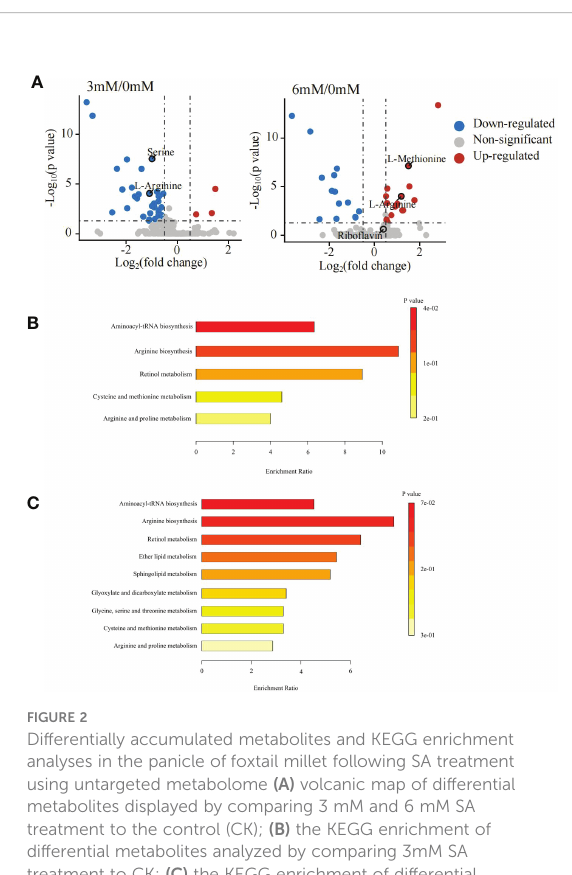
FIGURE 2 Differentially accumulated metabolites and KEGG enrichment analyses in the panicle of foxtail millet following SA treatment using untargeted metabolome (A) volcanic map of differential metabolites displayed by comparing 3 mM and 6 mM SA treatment to the control (CK); (B) the KEGG enrichment of differential metabolites analyzed by comparing 3mM SA treatment to CK; (C) the KEGG enrichment of differential metabolites analyzed by comparing 6mM SA treatment to CK.